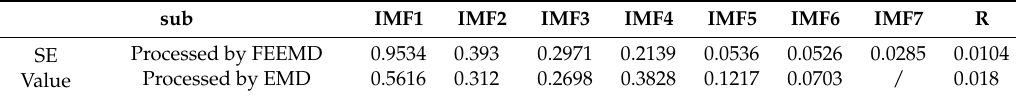
Table A9. The results of SE values under various decomposition methods.